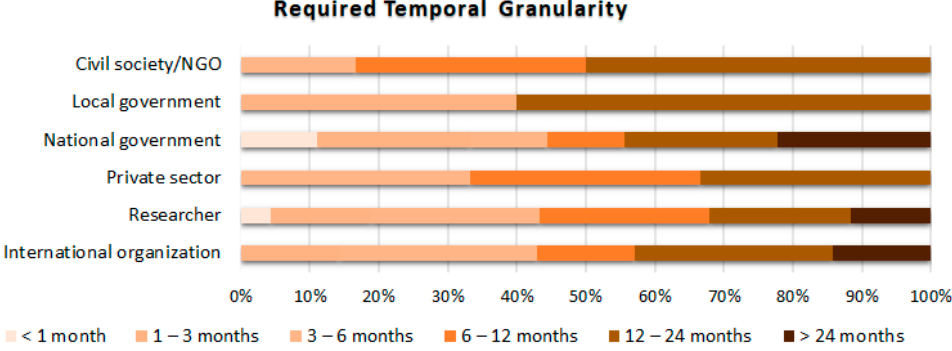
Figure 9. Results of online expert survey on the focus of work concerning deprived areas related data (multiple answers).